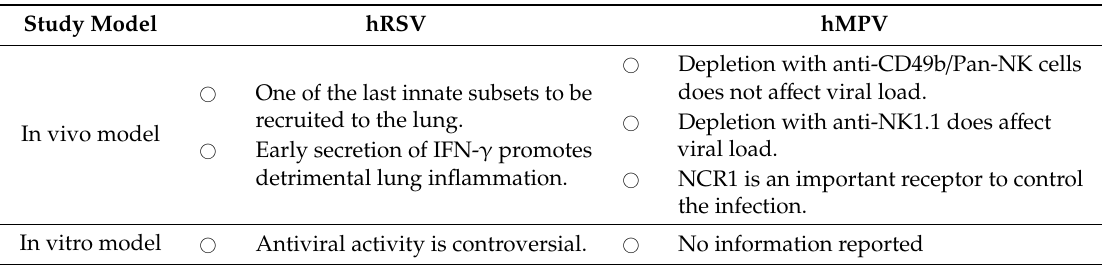
Table 5. Role of NK cells in the pathologies caused by hRSV and